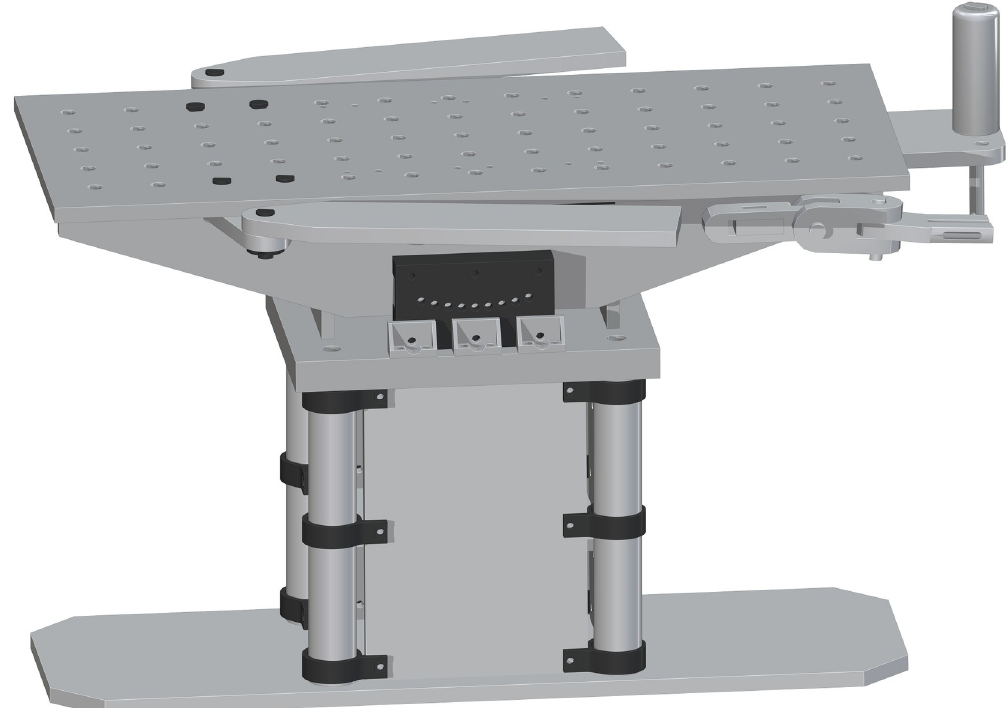
Fig 22. Addition of Peroneal Post Cover around the pelvic_post_mount.